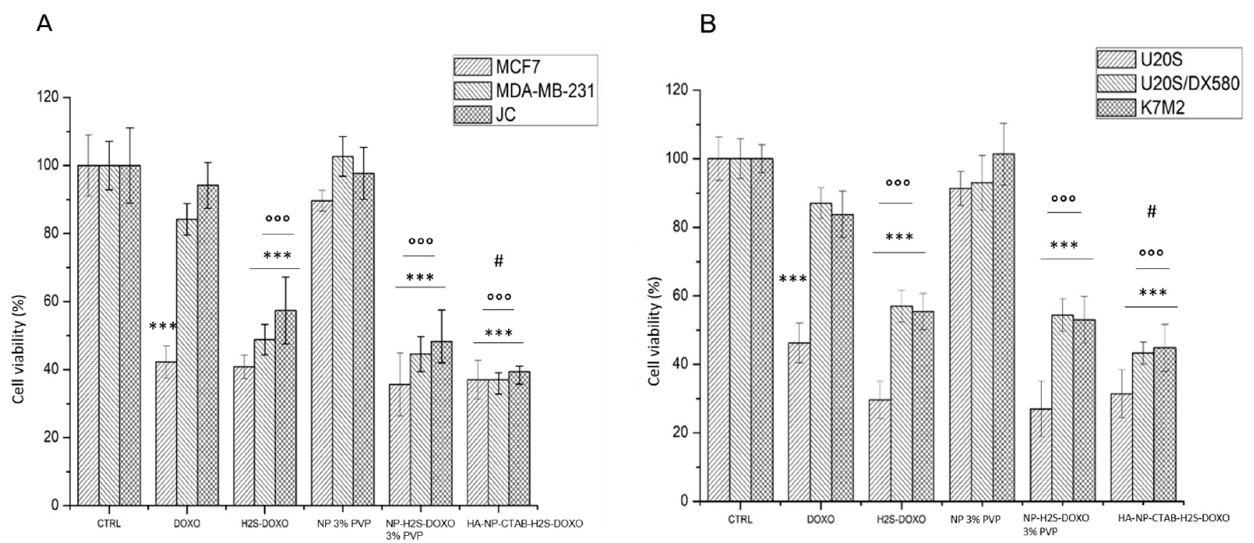
Figure 10. Cell viability: ( A ). breast cancer cells; ( B ). osteosarcoma cells. Cells were incubated 72 h with 5 µ M with free DOXO, free H 2 S-DOXO NP-H 2 S-DOXO 3% PVP, and HA-NP-CTAB-H 2 S-DOXO (containing 5 µ M H 2 S-DOXO), then the release of LDH was measured by a chemiluminescence-based assay (n = 4). Data are means + SD. *** p < 0.001: versus ctrl; °°° p < 0.001: versus DOXO; # p < 0.05: versus H 2 S-DOXO.